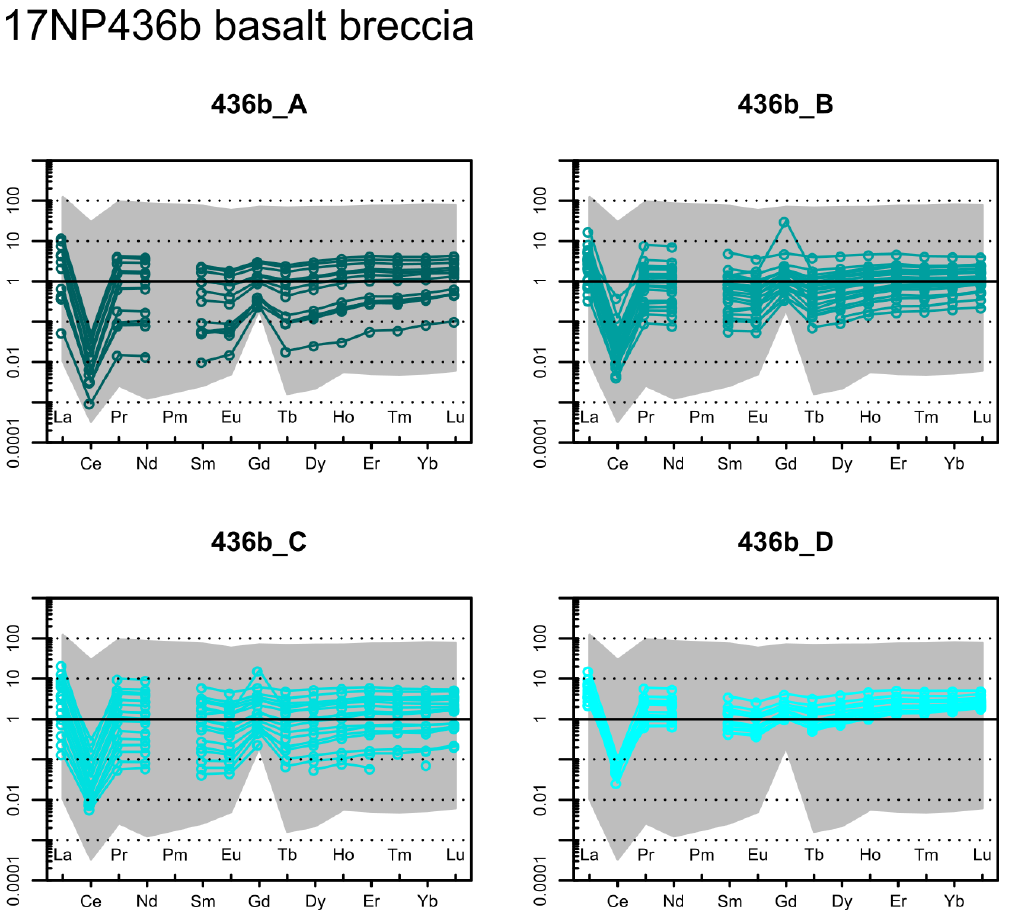
Figure C2. Rare earth element plots of each individual ablation area for sample 17NP436b. Grey shaded area in each diagram represents the range of chondrite-normalized REE concentrations in all calcite ablation